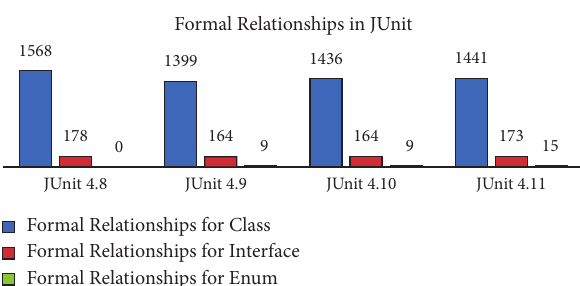
Figure 14: Count of formal relationships in Junit.